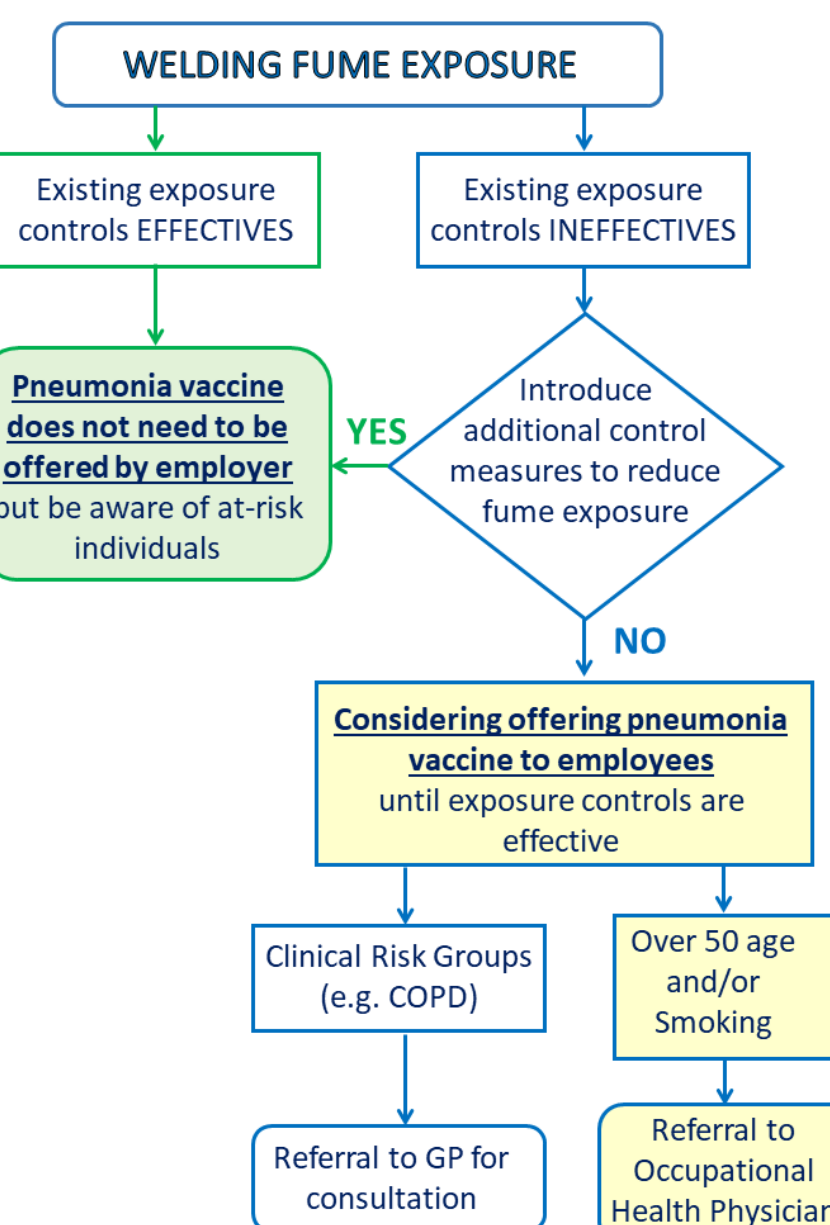
Figure 3. Simple pneumonia vaccine decision scheme. COPD: chronic obstructive pulmonary disease; GP: general practitioner.